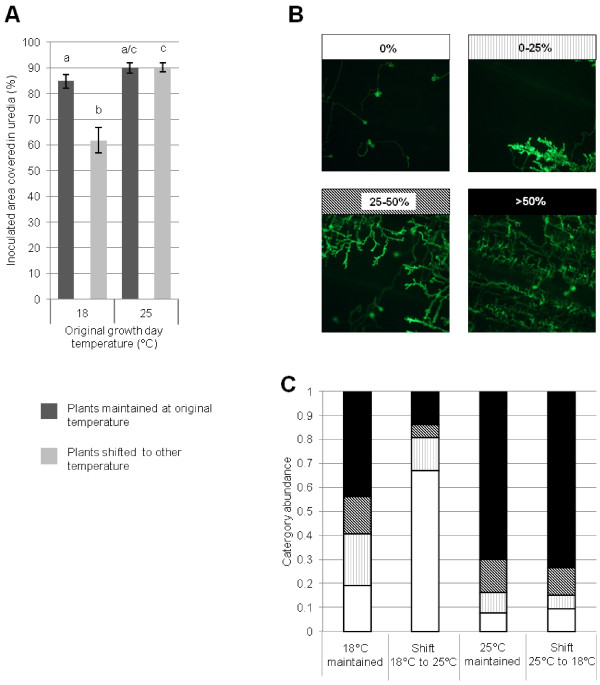
The effect of changes in temperature on Pst development in seedlings of the wheat line UC1041 - Yr36. A) Mean leaf area (%) covered in uredia 18 dpi on UC1041 -Yr36 seedlings. Leaves were inoculated with Pst isolate 08/21 and kept at the original temperature regime of 12°C/18°C or 12°C/25°C pre and post inoculation (dark grey) or transferred to the other temperature regime post-inoculation (light grey). Mean values (± 1 standard error) were obtained from up to 50 fields of view in three independent experiments. Different letters indicate statistically significant differences (P < 0.01). B-C) Microscopic characterisation of Pst development as categorised by the extent of hyphal colonisation. B) Illustration of Pst hyphal abundance, with each category of abundance being represented by different cross-hatching (upper panel). C) Frequency of occurrence of each category in each temperature treatment. Mean values for each category were obtained from three biological replicates.